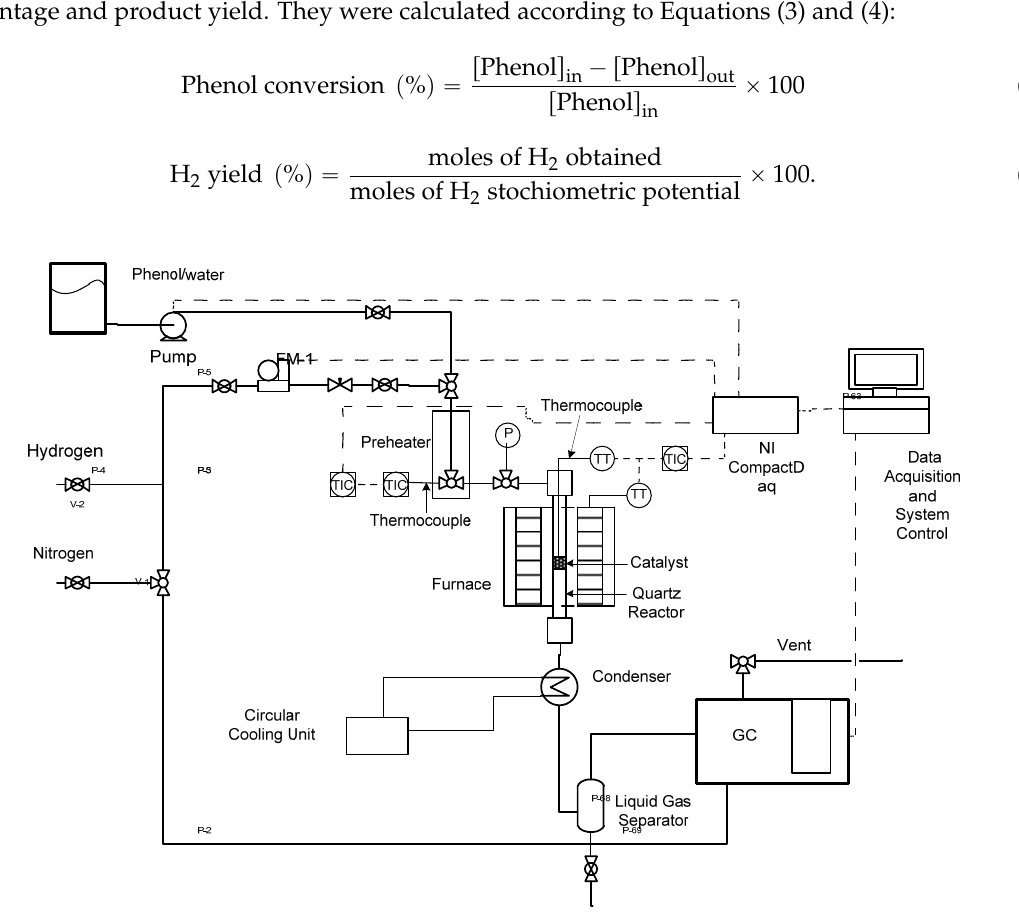
Figure 1. Schematic flow diagram of experimental setup.